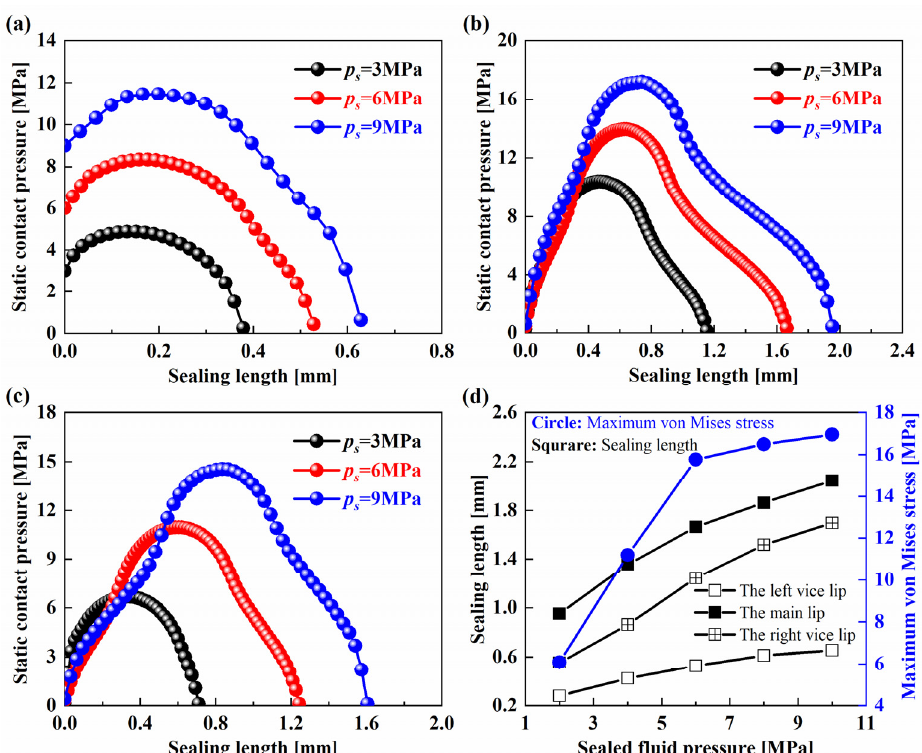
Figure 5. Contact pressure and stress distributions: ( a – c ) the static contact pressure distributions of the left lip, main lip, and right lip; ( d ) sealing length and maximum von Mises stress distributions.